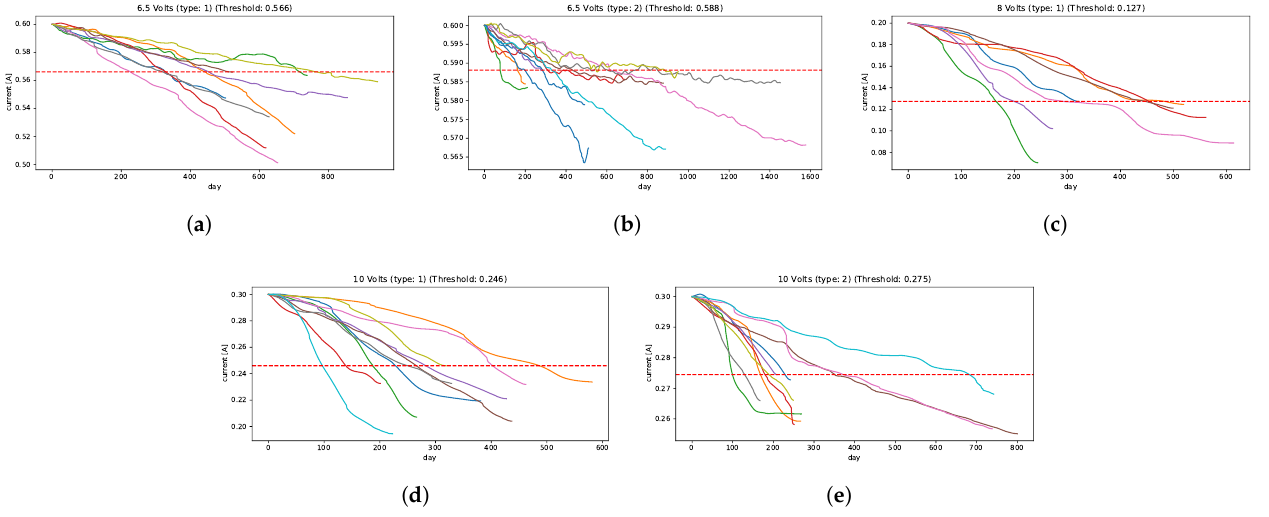
Figure 11. The IFP signals clustering, the red dashed lines represent the failure threshold defined for each cluster, and continuous lines are the critical segments segmented from the run-to-failure IFP signals ( a ) Class 1: 6.5 Volts (Degradation type 1). ( b ) Class 2: 6.5 Volts (Degradation type 2). ( c ) Class 3: 8 Volts. ( d ) Class 4: 10 Volts (Degradation type 1). ( e ) Class 5: 10 Volts (Degradation type